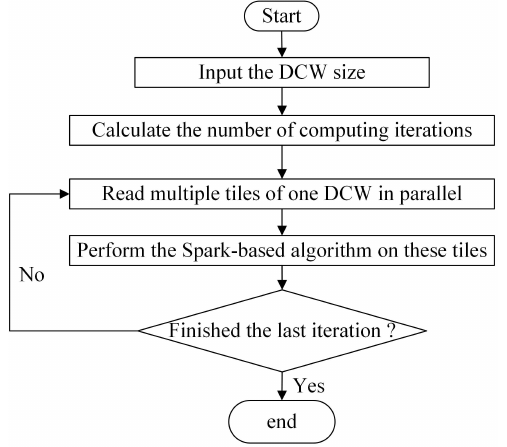
Figure 7. The flowchart of the computing